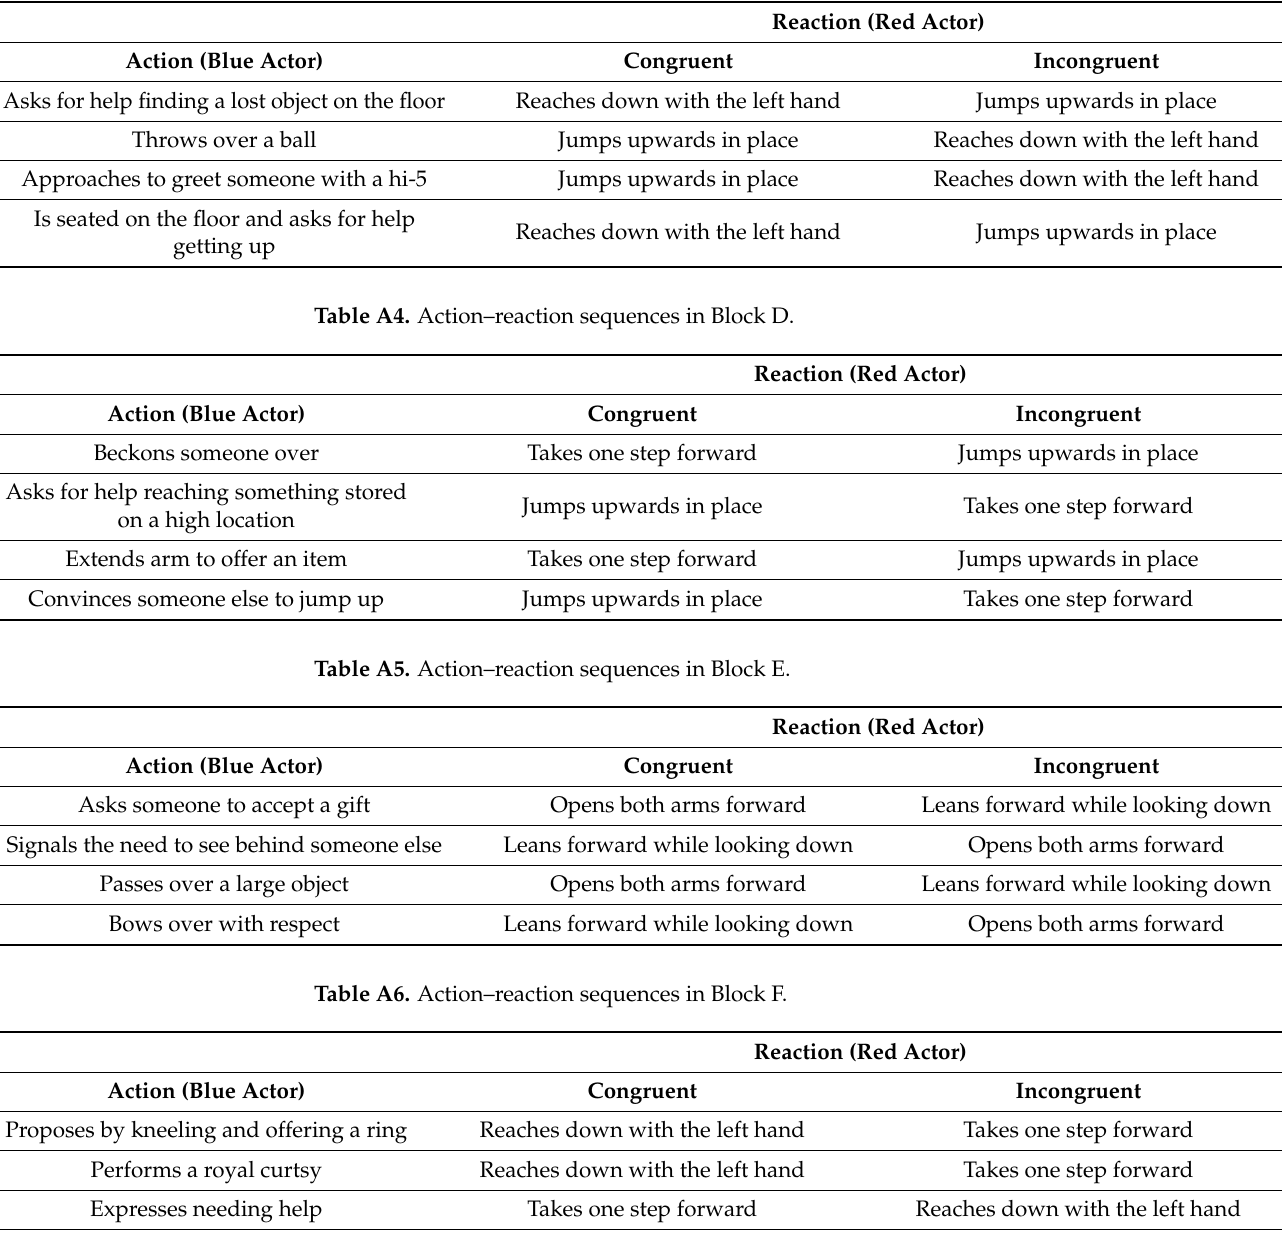
Table A3. Action–reaction sequences in Block C.